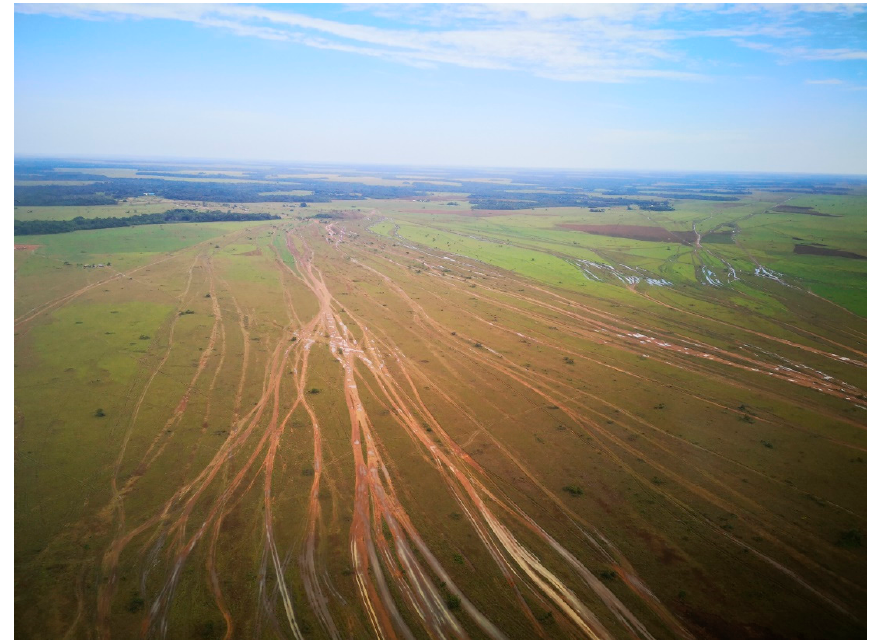
Figure 3. Network of roads that form the southwest limit of the Indigenous Santa Teresita del Tuparro reserve, Cumaribo, 2020. There is not one road that can be indicated as the main road. Source: Land in Peace Project, Kadaster.